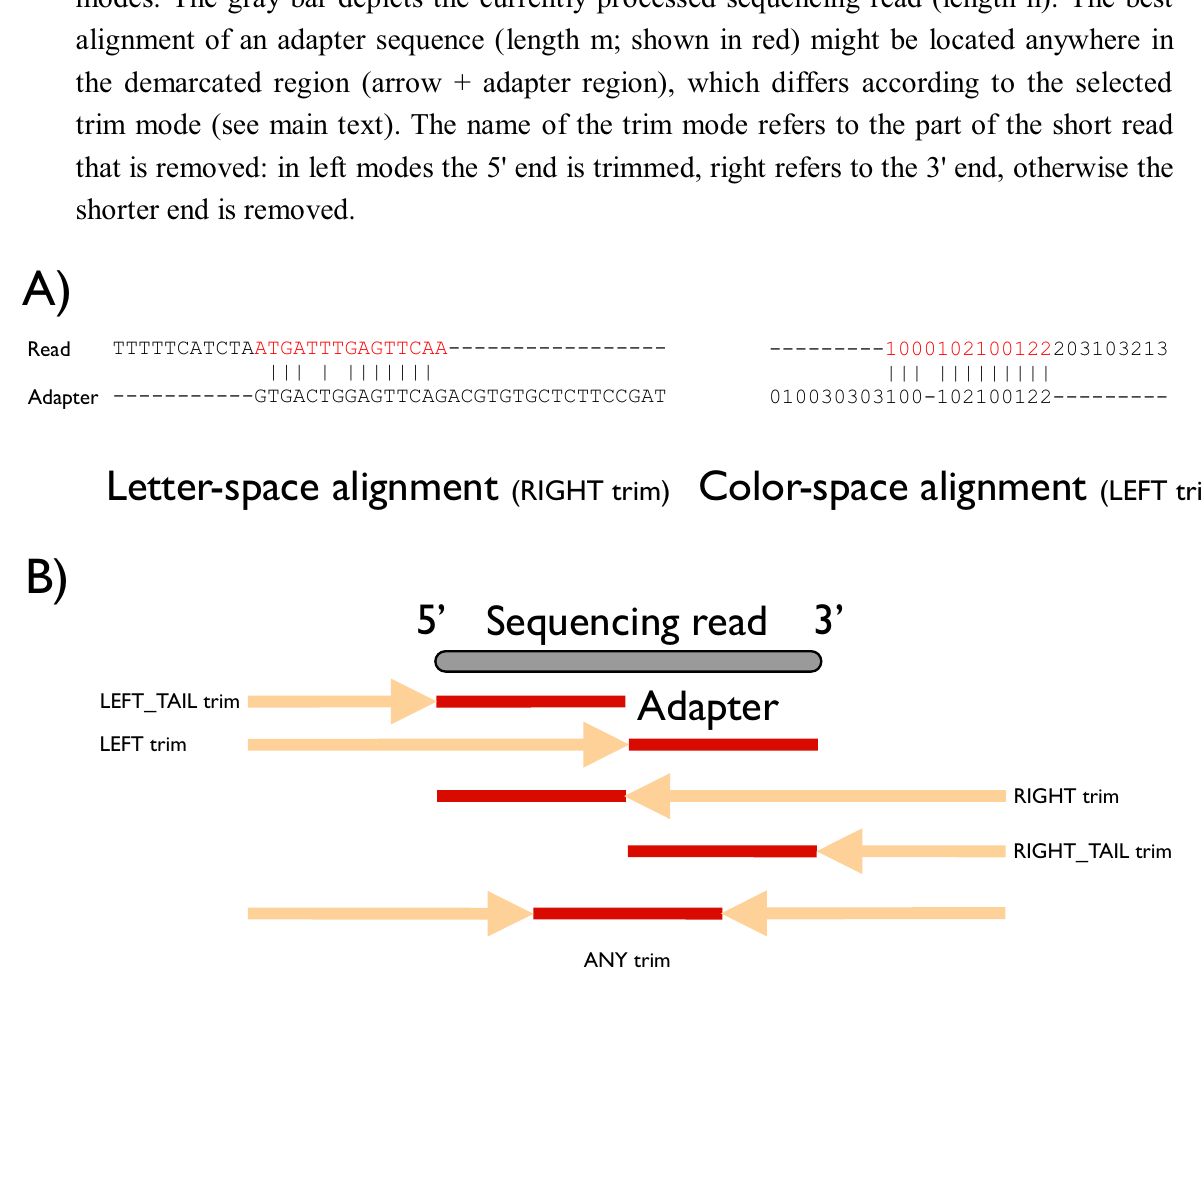
Color-space alignment (RIGHT trim)